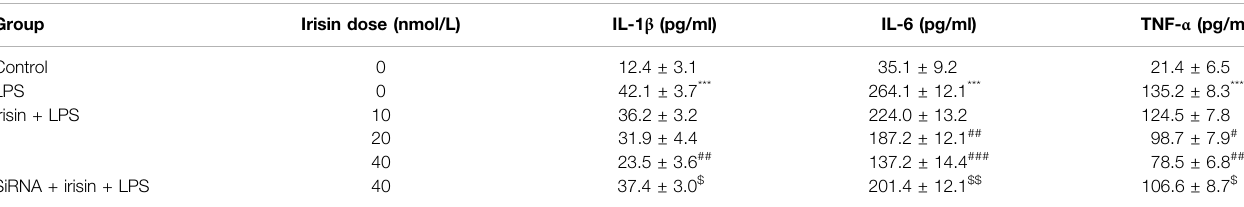
LPS, lipopolysaccharide. Values were expressed as mean ± SEM. Each group contains six rats. Data analysis was performed using Dunnett ’ s t-test. *** p < 0.001 vs. control group; # p < 0.05, ## p < 0.01 and ### p < 0.001 vs. LPS group; $ p < 0.05 and $$ p < 0.01 vs. LPS + 40 nmol/L irisin